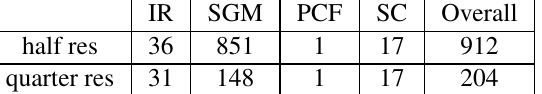
Table 1. Runtime in minutes of Image Registration (IR), Semi- Global Matching (SGM), Point Cloud Fusion (PCF) and Scene Classification (SC). The input in the first row are the images in half resolution (res), while in the second row the images in quar- ter resolution are used. The overall runtime for the presented results (Figures 1 and 10) is 204